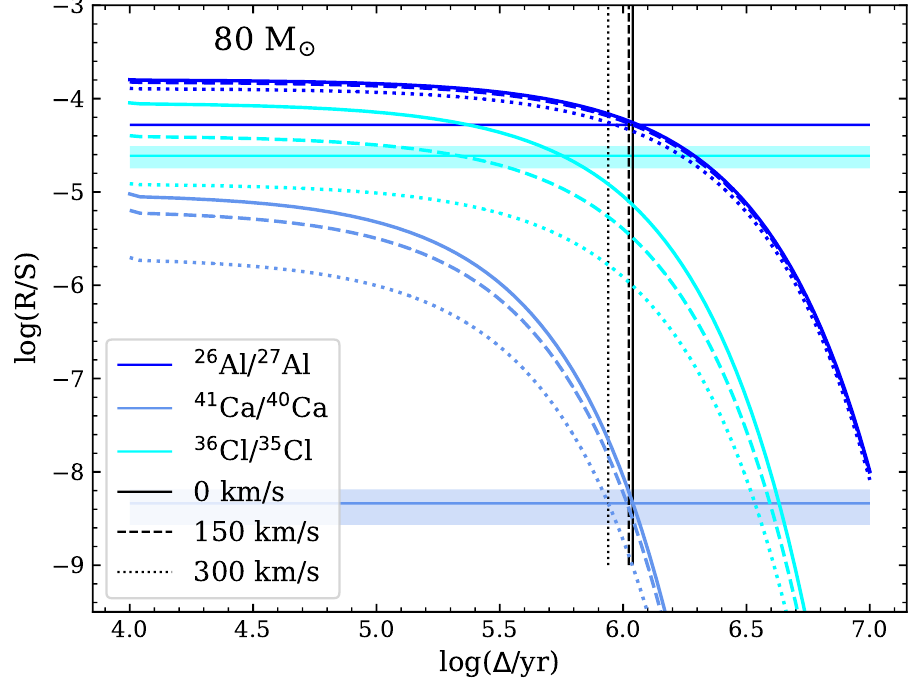
Figure 2. Previously published as panel (e) of Figure 7 in [47], ©AAS, reproduced with permission. Abundance ratios (R/S) for the SLR 26 Al, 36 Cl, and 41 Ca over their stable reference isotope ( 27 Al, 35 Cl, and 40 Ca) for a dilution factor f in the range 0.16–0.5 × 10 − 4 . These values are calculated as M ESS ( 26 Al)/ M star ( 26 Al), where M ESS ( 26 Al) is the mass of 26 Al observed in the ESS and M star ( 26 Al) its stellar yield from the example stellar models of initial 80 M (cid:12) and different initial velocities as indicated. The horizontal bands represent the ESS ratios, with their respective errors. The vertical lines represent the delay time, i.e., the time interval needed to match the ESS 41 Ca/ 40 Ca ratio, typically of the order of 1